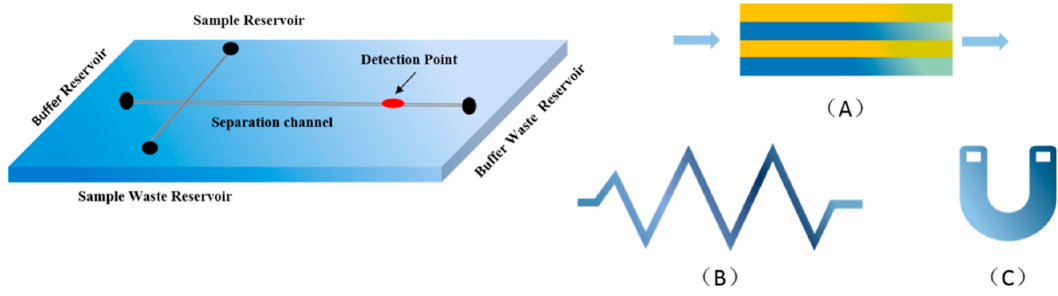
Figure 1. The structure of common microfluidic chip channel and variable styles of passive mixers. ( A ) Lamination; ( B ) Zigzag channels; ( C ) Serpentine.